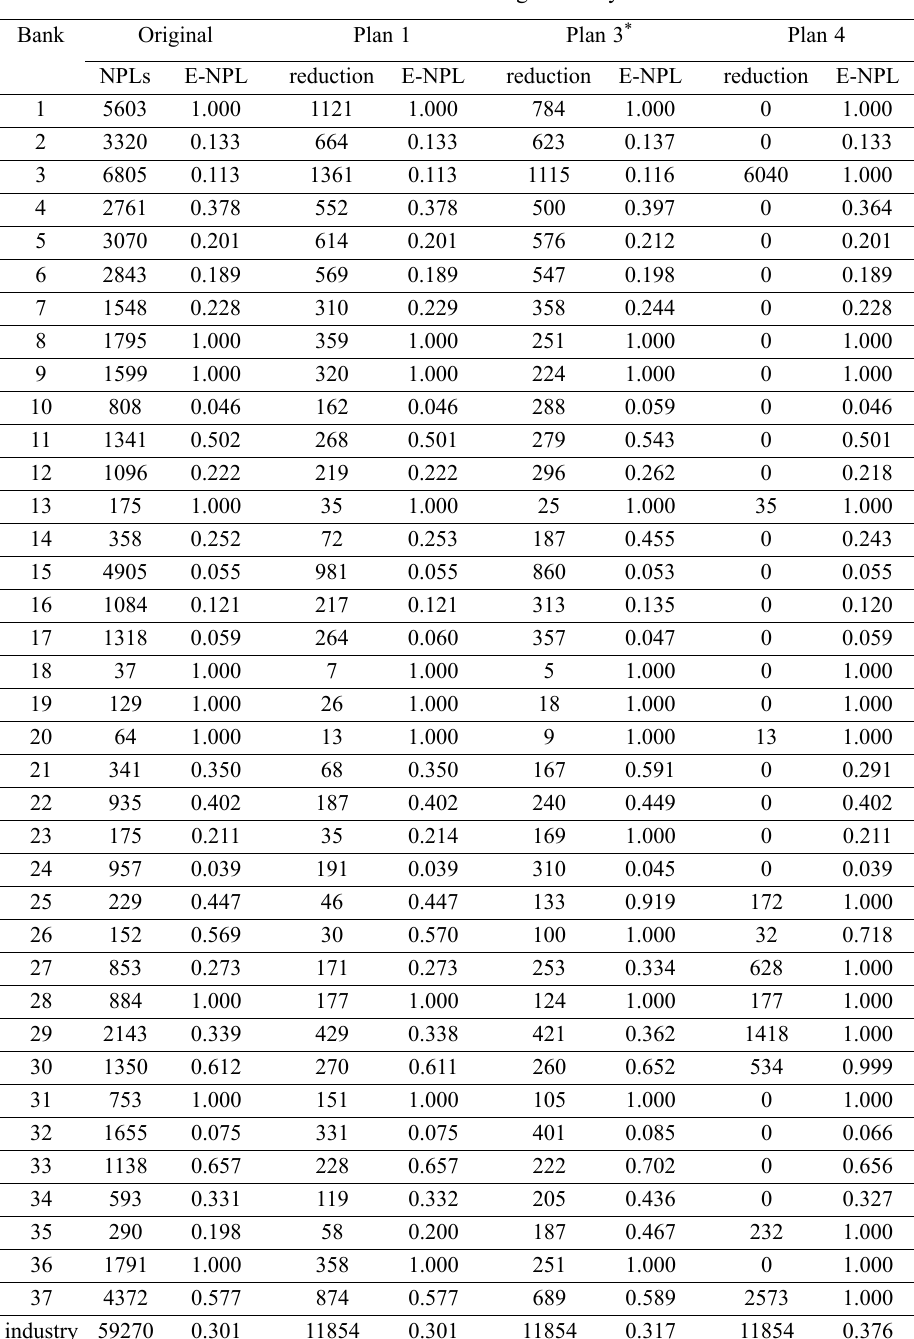
Table 2. Scenario of reducing NPLs by